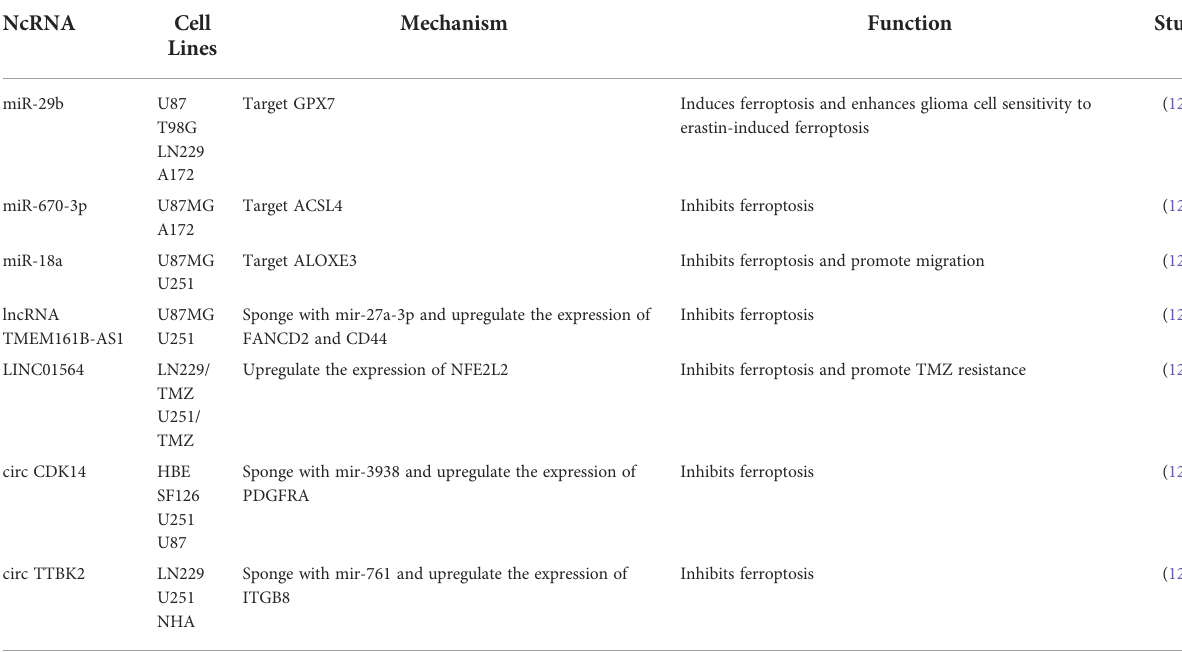
TABLE 2 The regulatory role of ferroptosis-related ncRNAs in glioma progression. NcRNA Cell